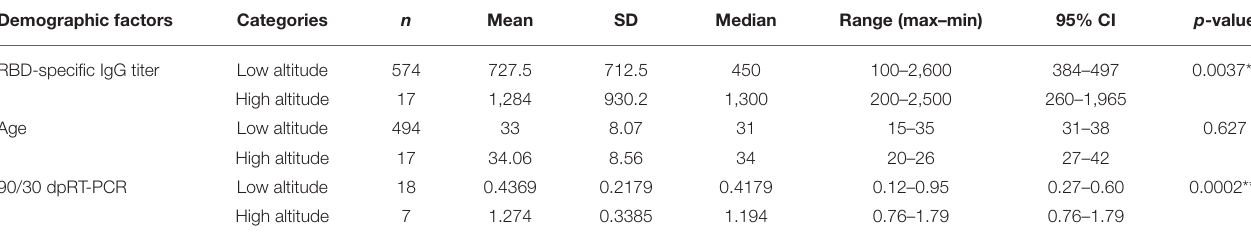
TABLE 4 | Statistical parameters of the comparison between anti-RBD IgG antibodies elicited in individuals from low or high altitudes. Demographic